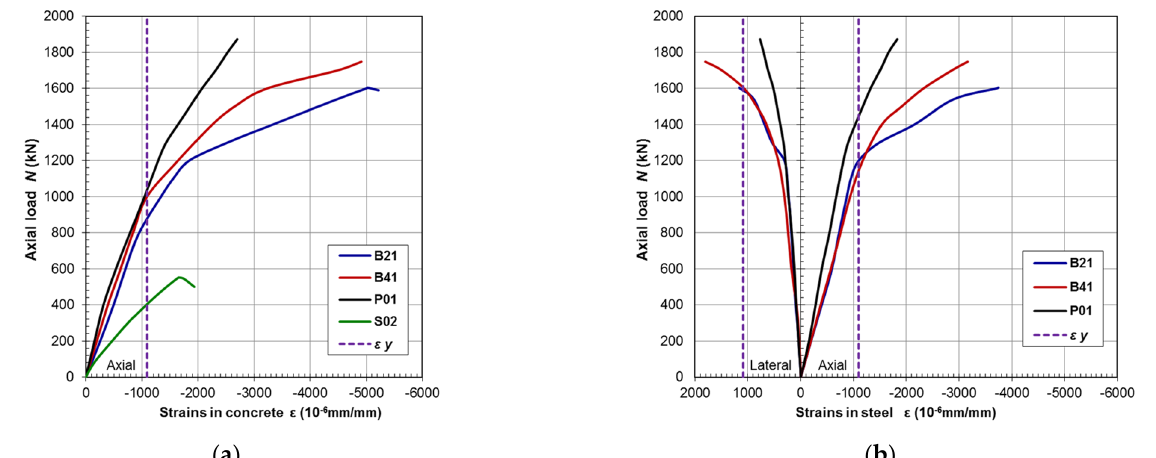
Figure 14. Comparative relationships of load versus strains on test specimens. Registered strains on concrete ( a ) and on steel jacket ( b ).